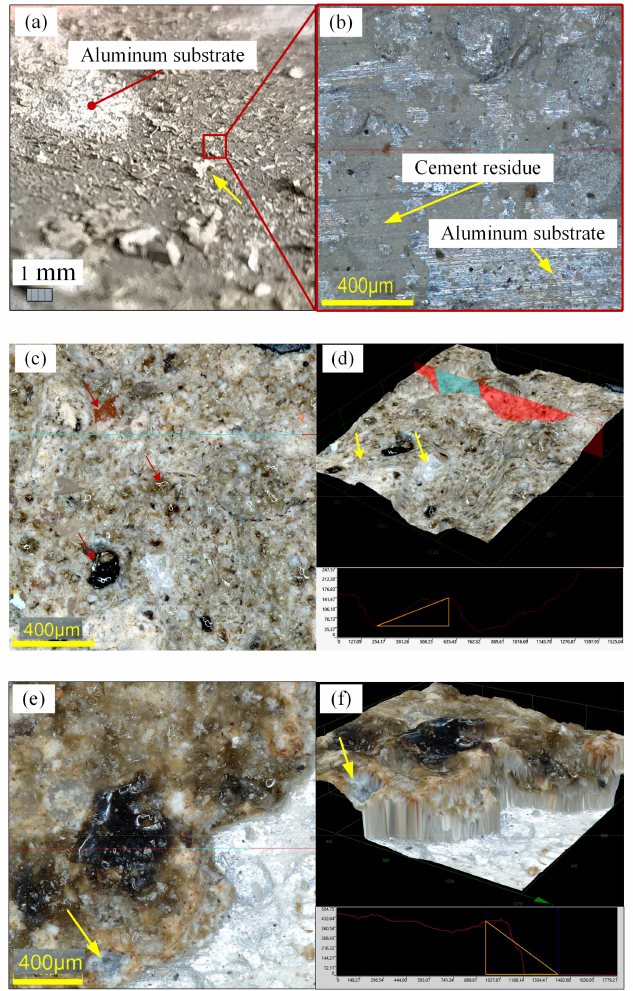
Figure 6. Typical micro-morphology at 2 (cid:13) ~ 4 (cid:13) in area B: ( a , b ) morphology at 2 (cid:13) ; ( c , d ) morphology at 3 (cid:13) ; ( e , f ) morphology at 4 (cid:13)